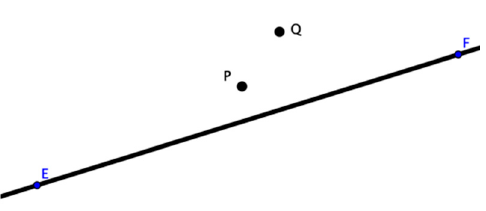
Figure 2 . How to construct a tangent circle to line EF that passes through point P & Q?